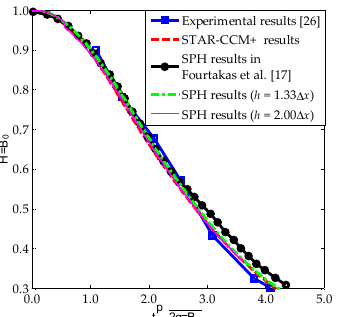
Figure 14. Comparison of the dimensionless height of the water column near the left wall ( ∆ x = 0.025 m )